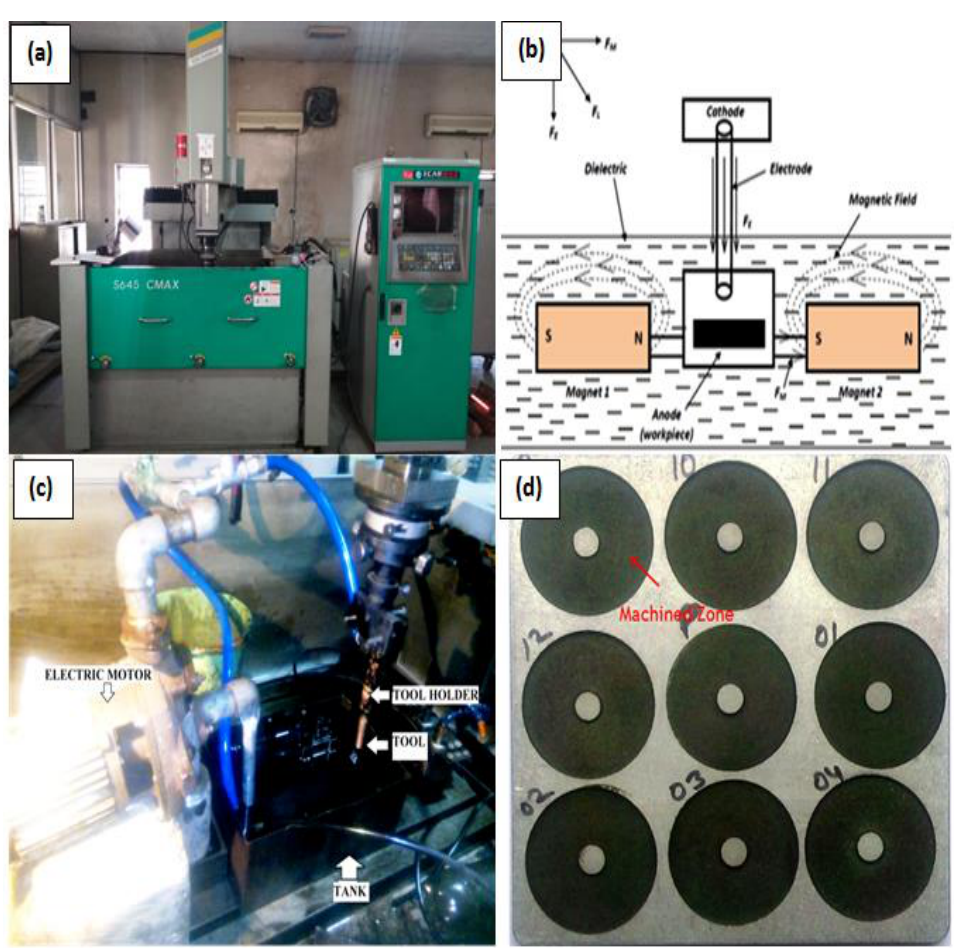
Figure 3. ( a ) EDM used for experimentation ( b ) Schematic diagram of MFAPEDM set-up and ( c ) Powder mixed dielectric set-up ( d ) machined Al-SiC workpiece. Table 2. Input parameters and their levels.